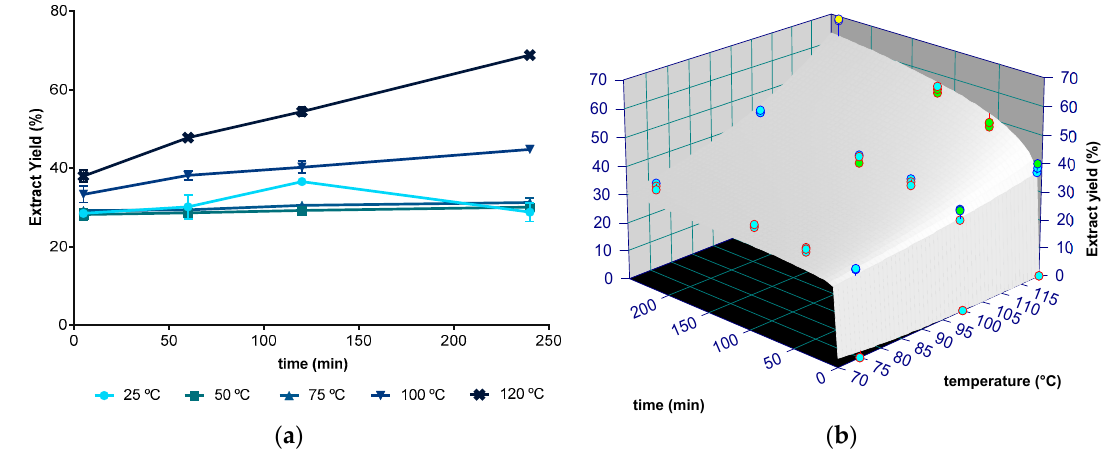
Figure 1. ( a ) Aqueous crude extract yield (g of dried extract / 100 g of dried seaweed) at 25, 50, 75, 100, and 120 ◦ C between 5 minutes and 4 hours. ( b ) Fitting plot of power law with Arrhenius dependence to the crude extract at 75, 100, and 120 ◦ C during 5 min to 4 h (240 min) (blue, green, and yellow, identify, respectively, 1, 2, and 3 standard deviations).